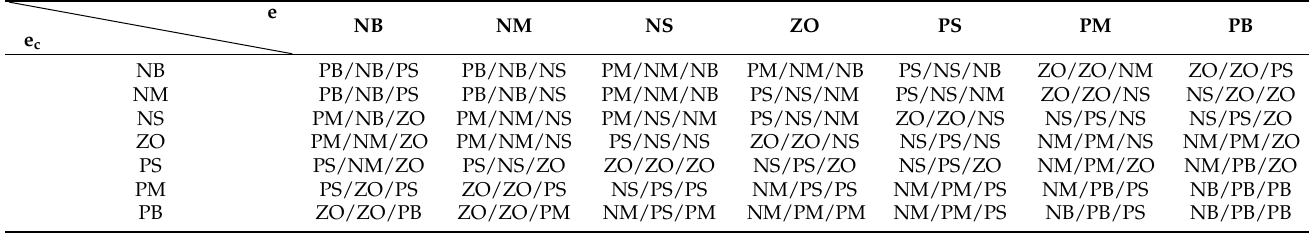
Table 2. Fuzzy rules of ∆ K p , ∆ K i and ∆ K d .